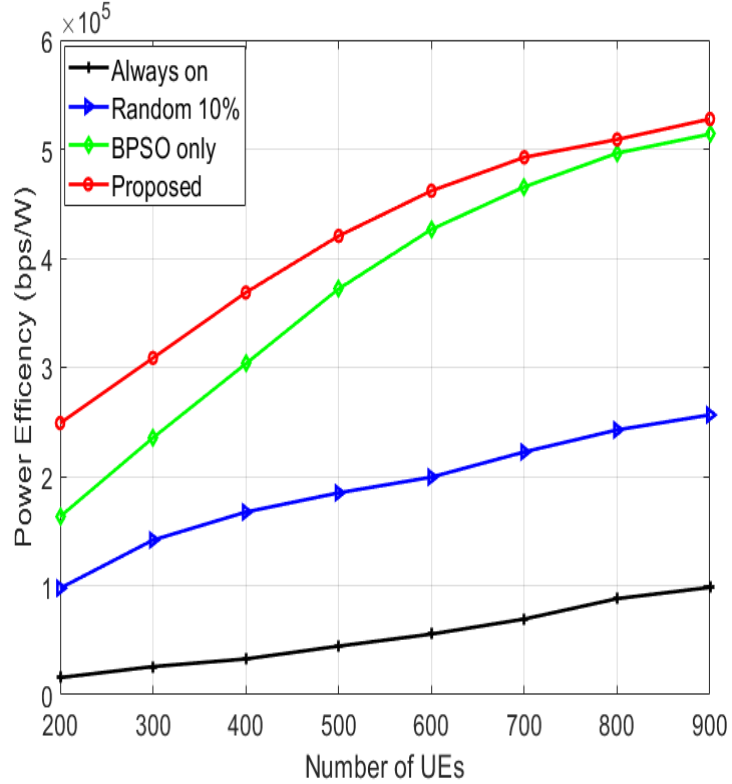
Figure 9. Power efficiency for various numbers of UEs.